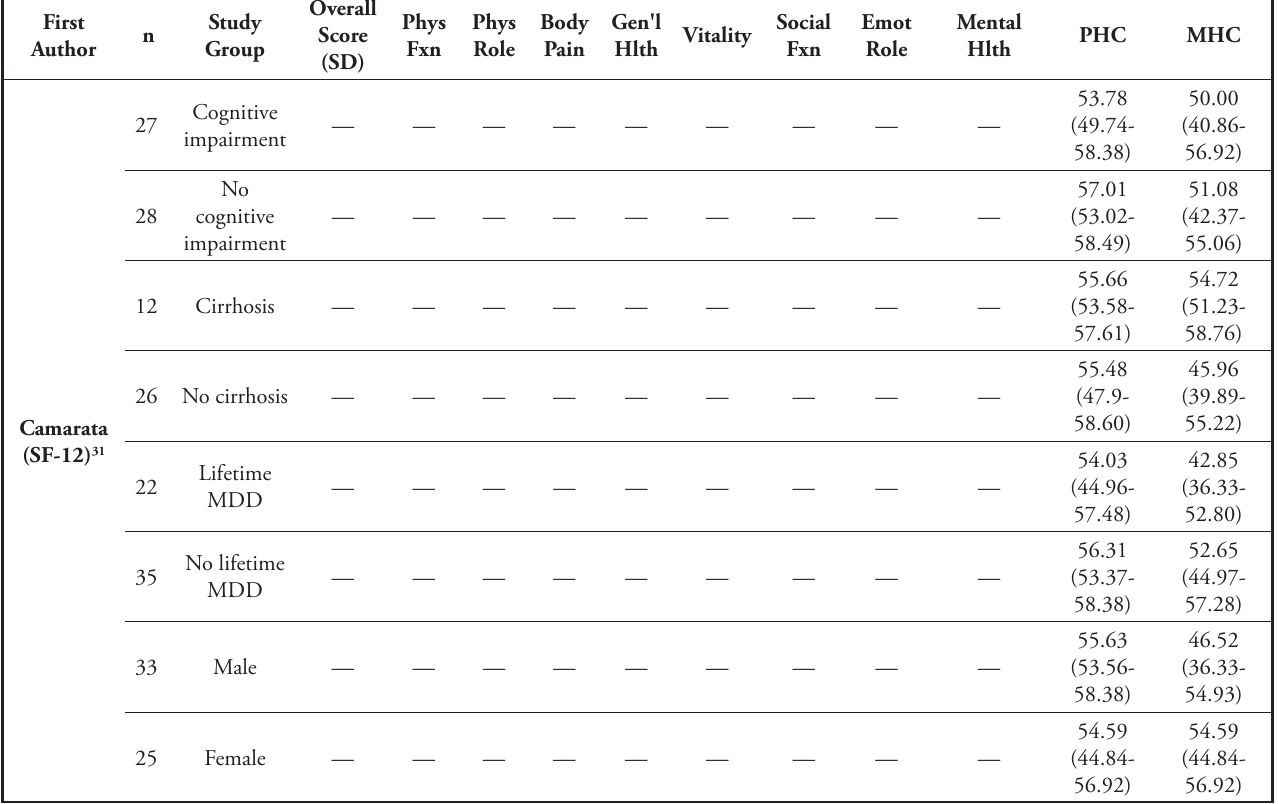
Table 3. SF-12/SF-36 Outcomes Assessed in Included Studies First